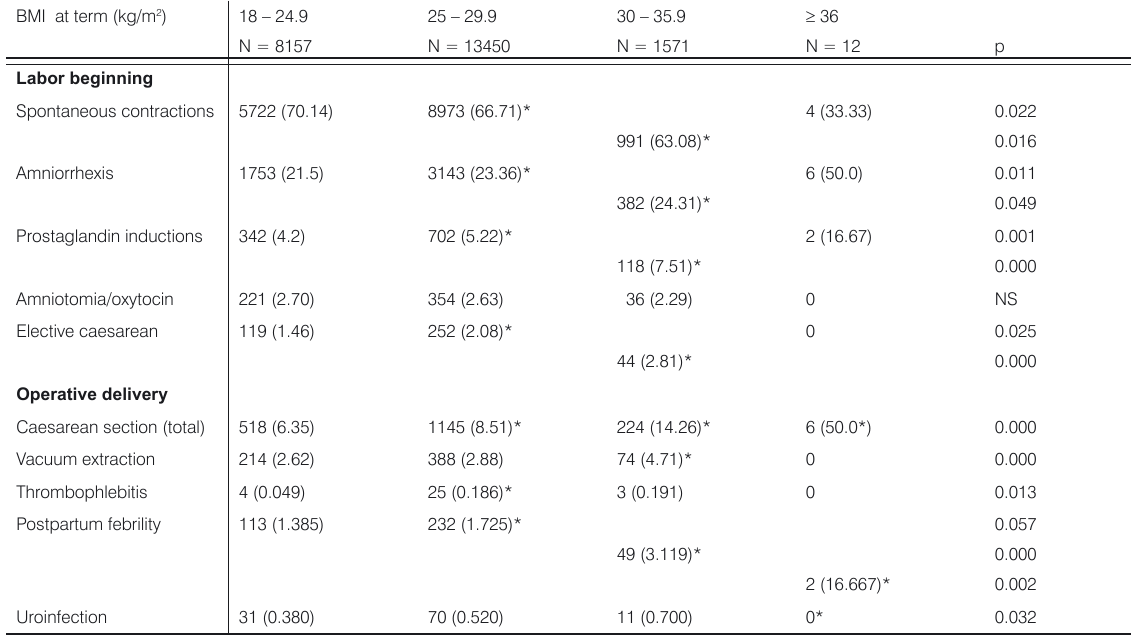
Table 4. Labor and early postpartum